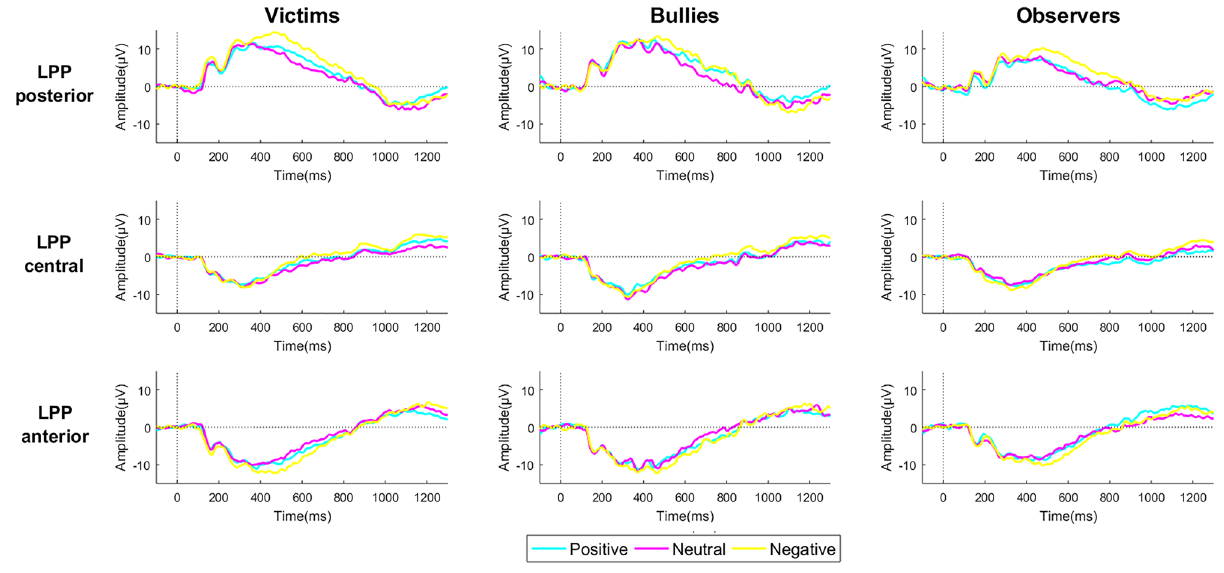
Figure 2. Grand average ERP LPP waveforms in the victim, bully, and observer groups in posterior, central, and anterior regions.